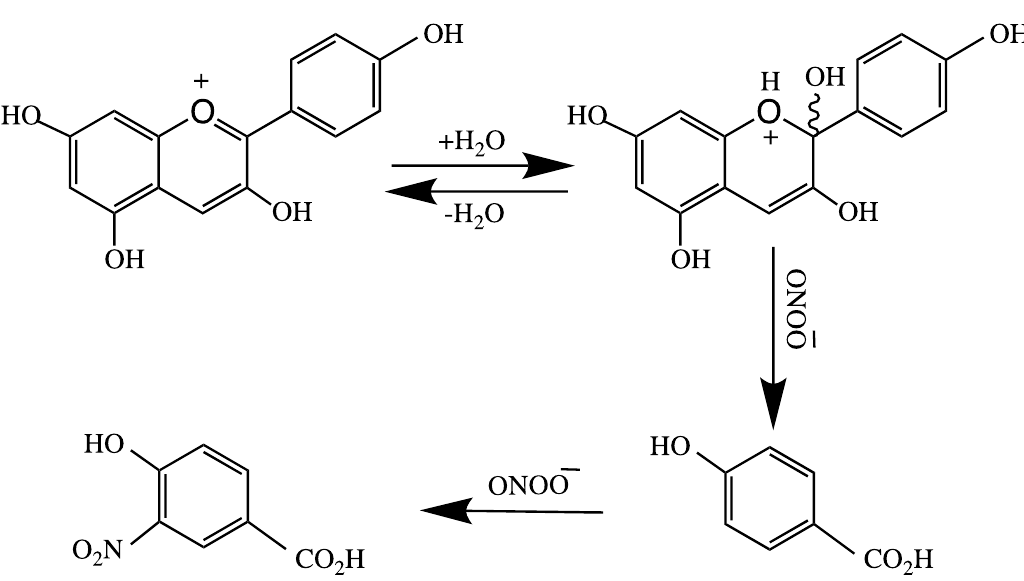
Figure 5. Peroxynitrite anion catalyzed splitting of ring B in anthocyanins.